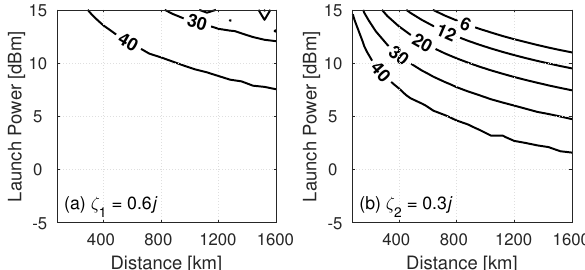
Figure 4. Performance of the baseline systems as a function of the distance. We show ( a ) The reciprocal of the EVM in dB for the eigenvalue ζ 1 = 0.6 j and ( b ) The reciprocal of the EVM in dB for the eigenvalue ζ 2 = 0.3 j . The level curves in these two sub-figures are for the following values of the reciprocal of the EVM: 6, 12, 20, 30 and 40